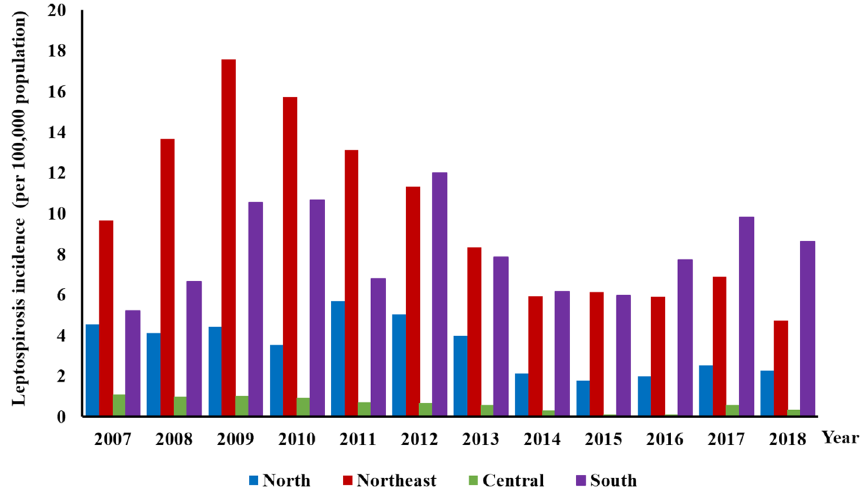
Figure 4. Distribution of human leptospirosis incidence by region in Thailand,